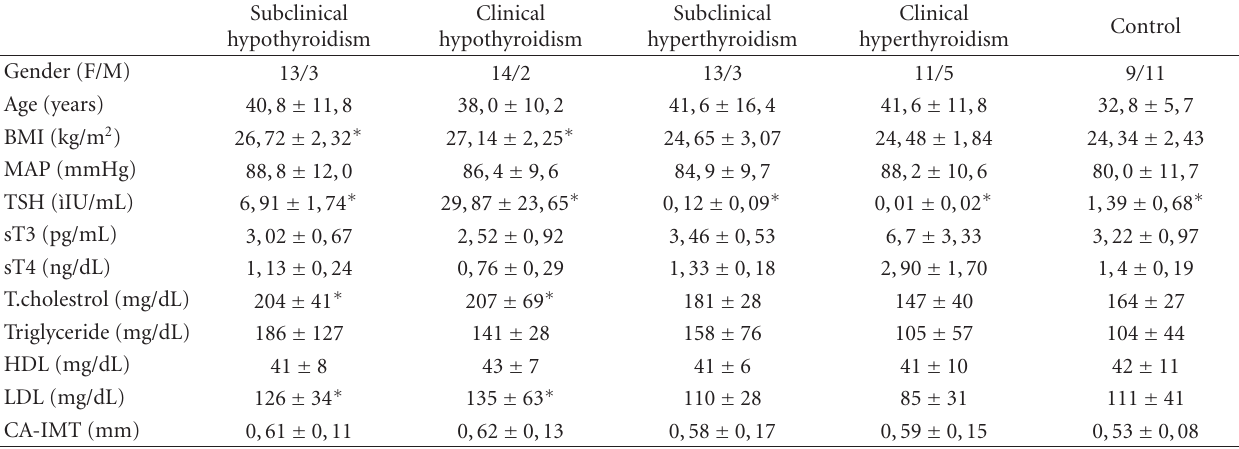
Table 1: Clinical and demographical characteristics of the patient population.